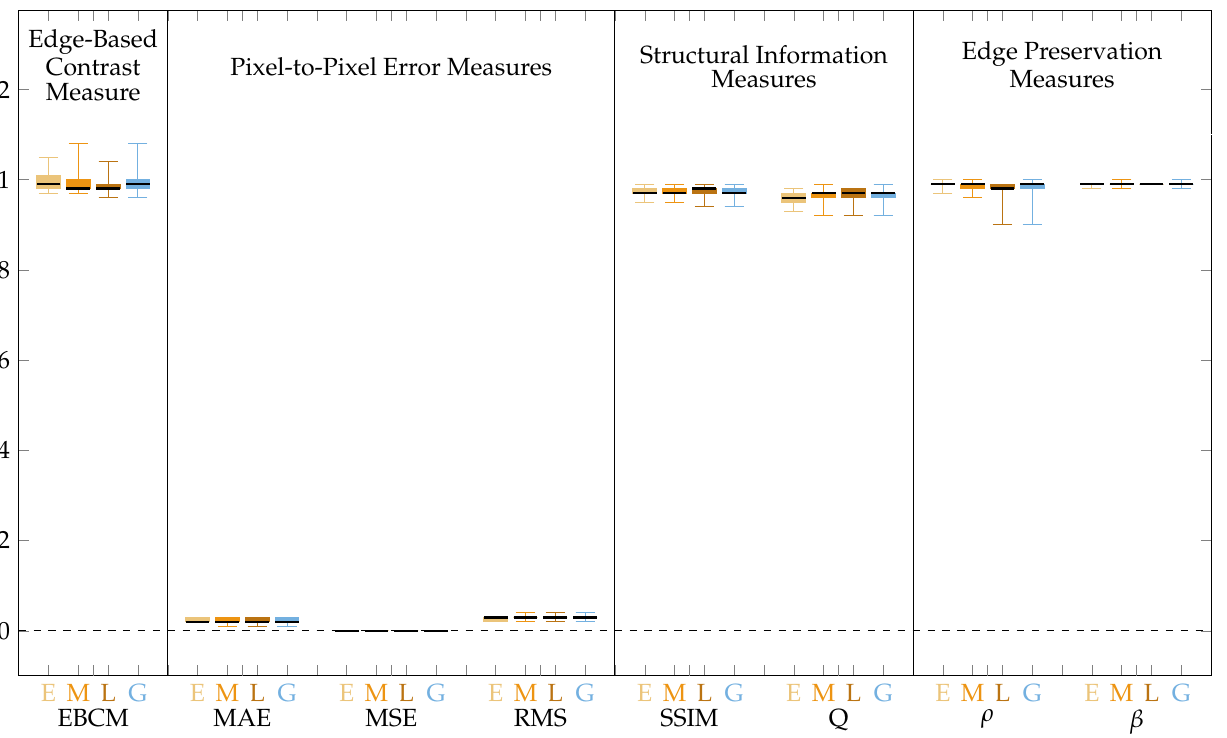
Figure 4. Quality measures for images processed by the proposed method. Measure values calculated from the central image regions only.